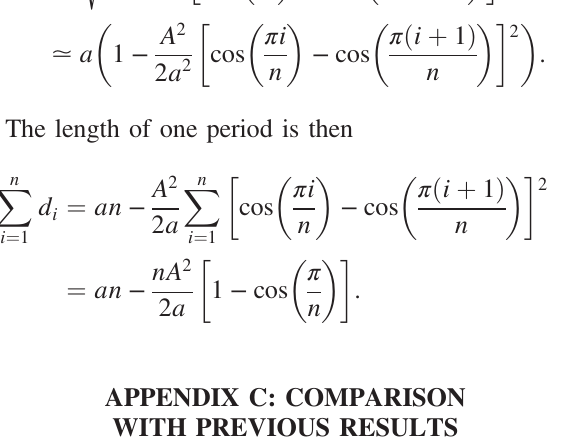
FIG. 7. Measurement of the time evolution of the normalized radius of an air bubble in water, for different values of Δ P .